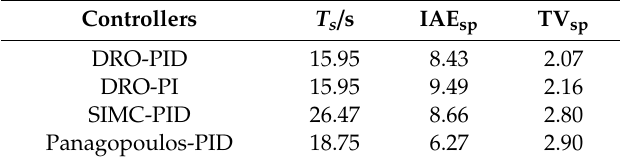
Figure 8. The control signal of the ramp input for Example 1. Table 4. The indices of Example 1 with different controllers for the ramp input.